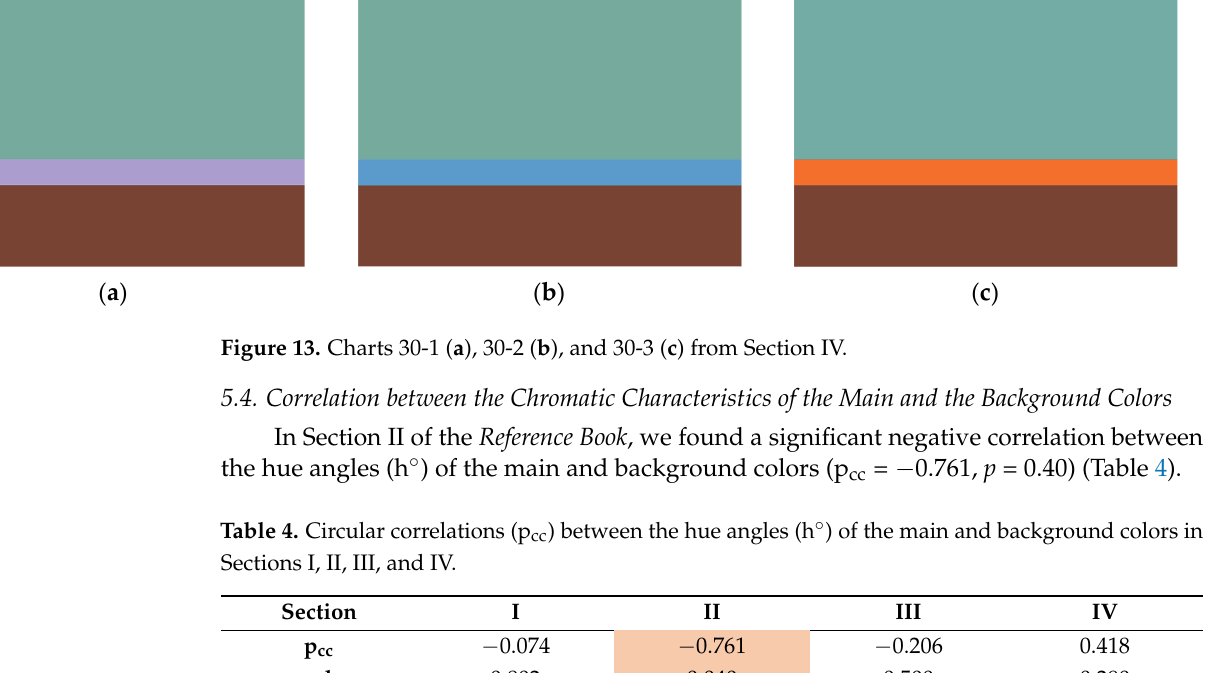
Figure 12. Charts 28-1 ( a ), 28-2 ( b ) 29-1 ( c ), and 29-2 ( d ) from Section IV. Matyushin uses the last three charts of Section IV (charts 30-1, 30-2, and 30-3) to demonstrate how the intermediary color can impact the perception of blue-green. In his comments to the charts (Matyushin [1932] 2007, p. 33), he points out that intermediary pale lilac makes the environmental background color “more balanced”; intermediary sky- blue “elicits green” in the background; high-chroma orange “visually lends the back- ground color greater depth and transparency” (Figure 13). Matyushin’s idea here was that such effects of the color combinations do not happen immediately. They require the viewer’s concentration, introspection, observation, time, and adaptation.